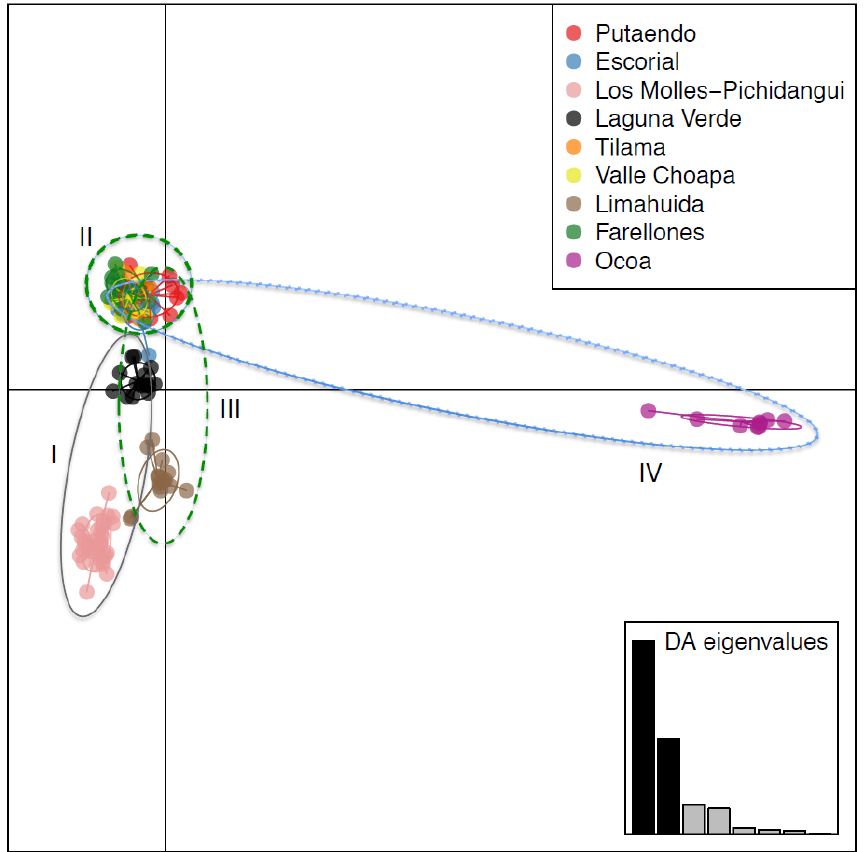
Figure 3. DAPC analysis for 150 individuals of Eriosyce curvispina based on 12 microsatellites loci. Ellipsoids depict Groups I–IV identified in the Bayesian phylogenetic inference in Figure 2.